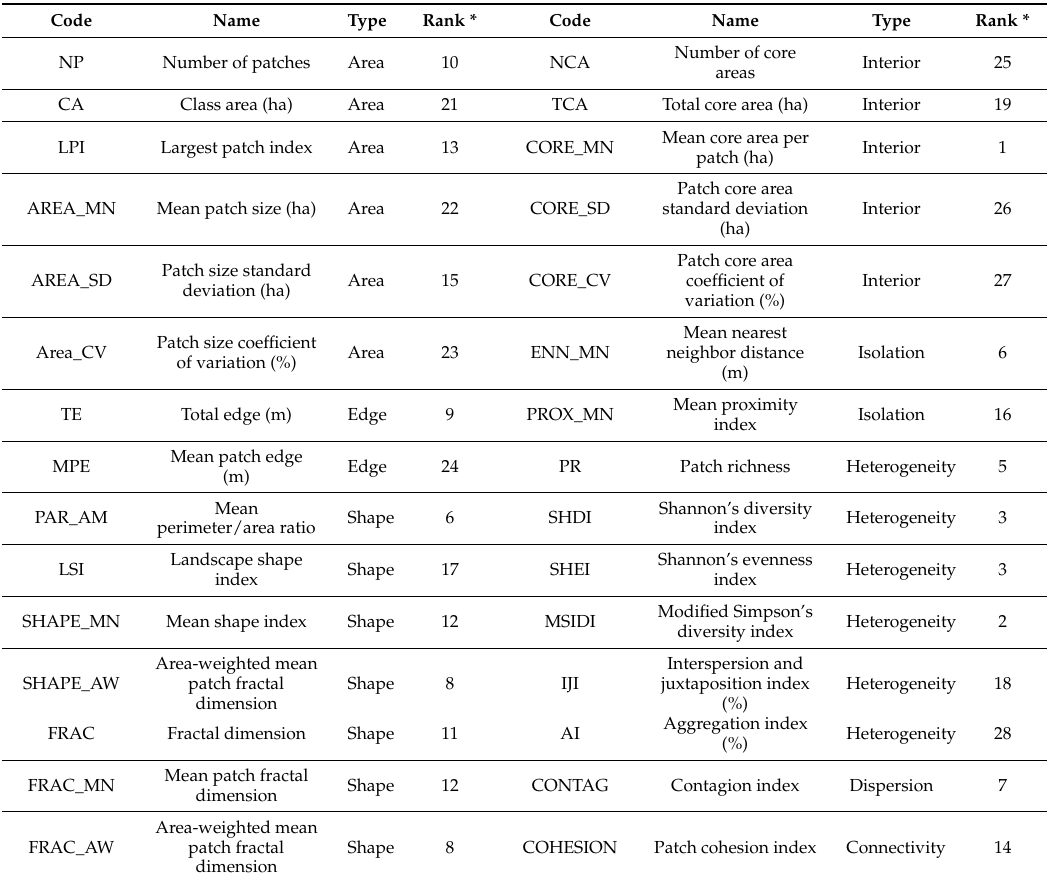
Figure 2. Land cover classification in different years for the Liverpool Plains (LP) and Liverpool Range (LR) provinces (refer Section 3.1 for class descriptions). Table 1. List of landscape metrics used in this study [13]).